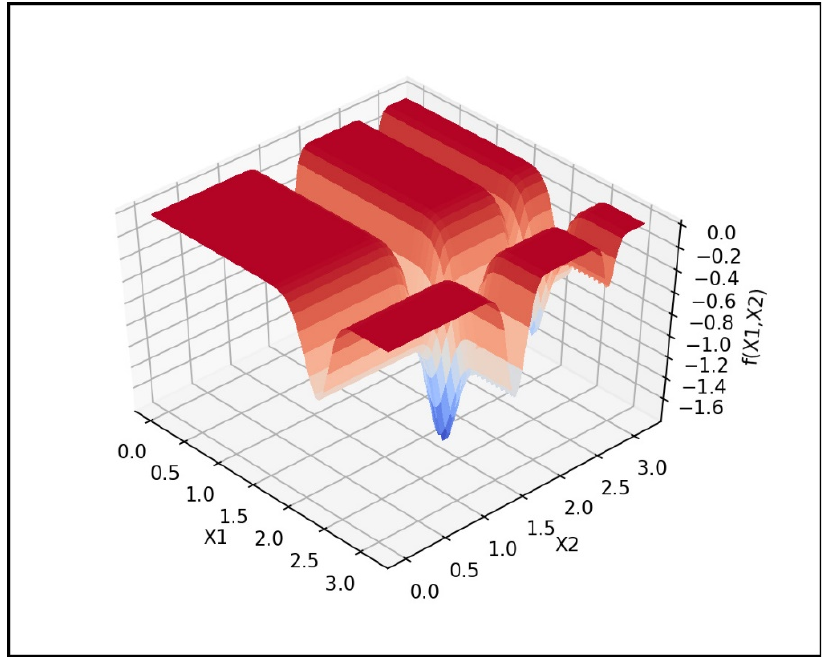
Figure 1. The 2D plot of F10 function.